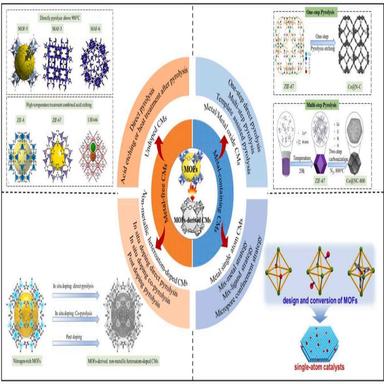
Schematic illustration of the classification and preparation strategies of MOFs-derived CMs.